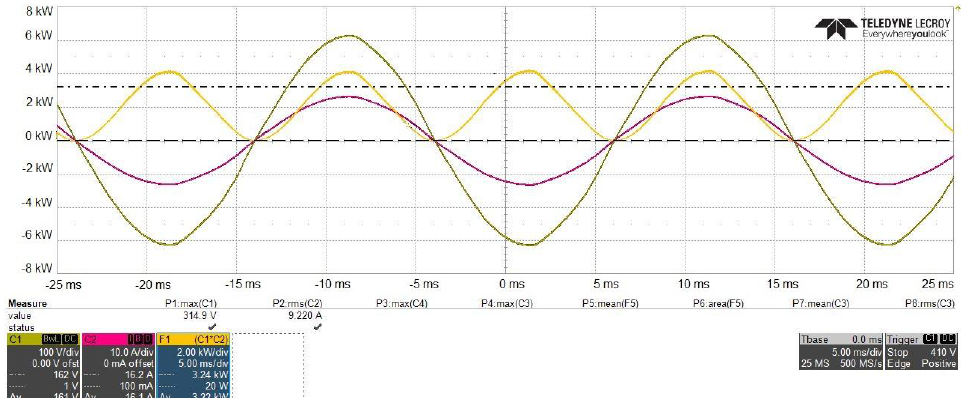
Figure 16. Voltage (C1, green), current (C2, purple), and power (F1, yellow) of the mains in direct connection.